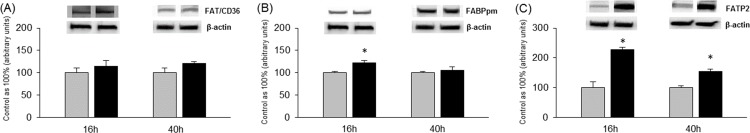
Expression of proteins involved in plasmalemmal transport of fatty acids i.e. FAT/CD36 (A), FABPpm (B) and FATP2 (C) in primary rat hepatocytes.Cells were incubated in high glucose DMEM culture medium without (Control group) or with palmitate (0.75 mM) (Palmitate group) for 16h and 40h. Thereafter primary hepatocytes from each experimental group were prepared as it was described previously in Materials and Methods. Protein concentration was measured by BCA method. Total expression of these proteins were analyzed by western blotting. The data are expressed as the mean ± SEM and are based on six independent determinations (n = 6). *P<0.05 significant difference: Control group vs. Palmitate group. Grey bars are referred as control groups and black bars are referred as palmitate groups.